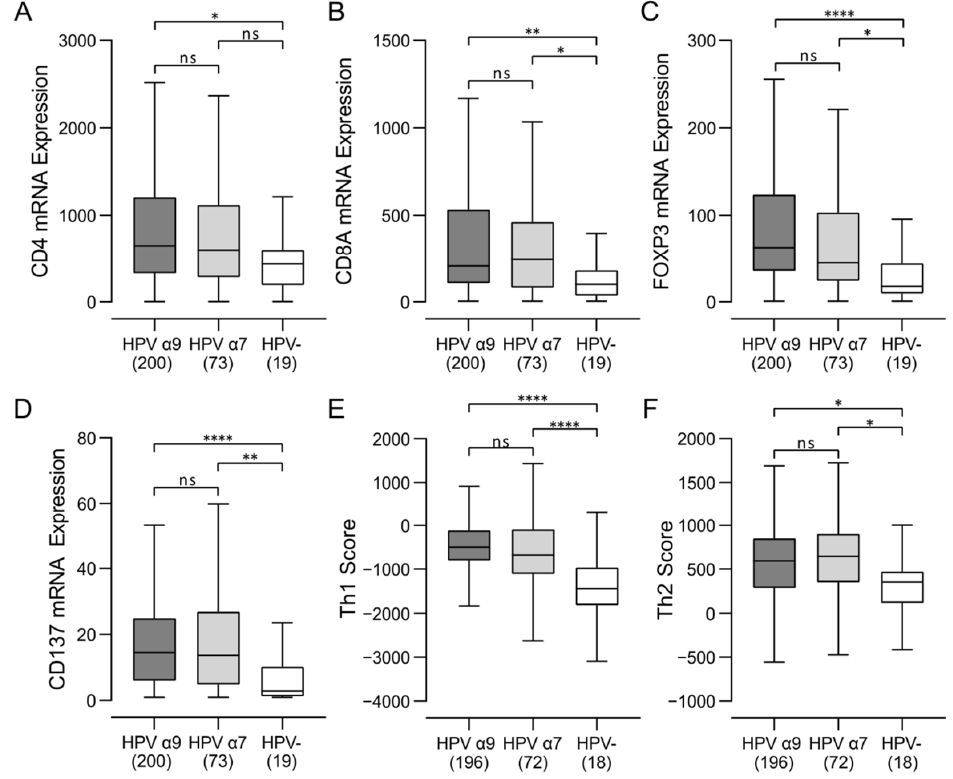
Figure 3. Analysis of T-cell populations in HPV-positive and HPV-negative cervical cancers. ( A – C ) Expression of marker genes related to CD4 + helper (CD4), CD8 + cytotoxic (CD8A), and Treg (FOXP3) cells; ( D ) expression of CD137 (TNFRSF9/4-1BB), an activation-induced costimulatory molecule pre- sent primarily on CD8 + T cells. ( E , F ) Comparison of CD4 + helper Th1 and Th2 Signature Score be- tween HPV α 9, HPV α 7, and HPV-negative (HPV-) cervical cancers. Numbers in brackets refer to the number of samples included in each analysis. **** p ≤ 0.0001, ** p ≤ 0.01, * p ≤ 0.05, ns (not signif- icant).